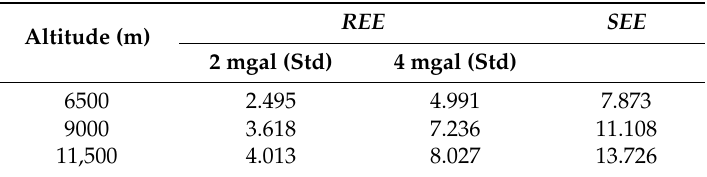
Table 8. Errors Effect and downward continuation altitude in Tibetan Plateau